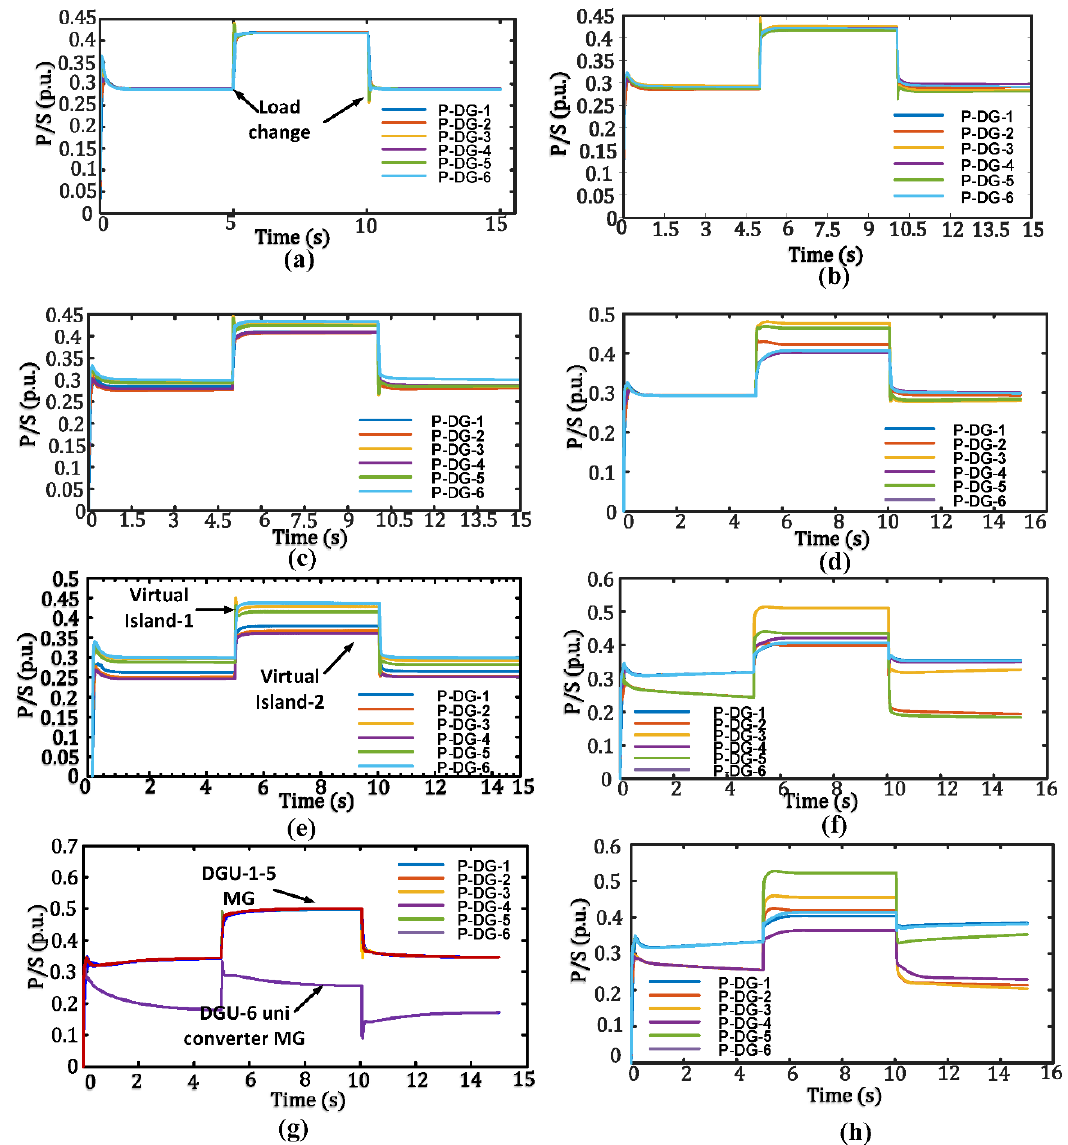
Figure 5. Comparison of active power sharing under proposed control strategy and conventional consensus-based control with varying communication network health: ( a ) Full ring connectivity with proposed control; ( b ) Full ring connectivity with consensus-based control; ( c ) Triple link failure, three sub-islands with proposed control; ( d ) Triple link failure, three sub islands with consensus-based control ( e ) Dual link failure, two sub islands with proposed control ( f ) Dual link failure, two sub islands with conventional consensus-based control ( g ) Dual link failure, two asymmetrical sub islands with proposed control ( h ) Dual link failure, two asymmetrical sub islands with consensus-based control.